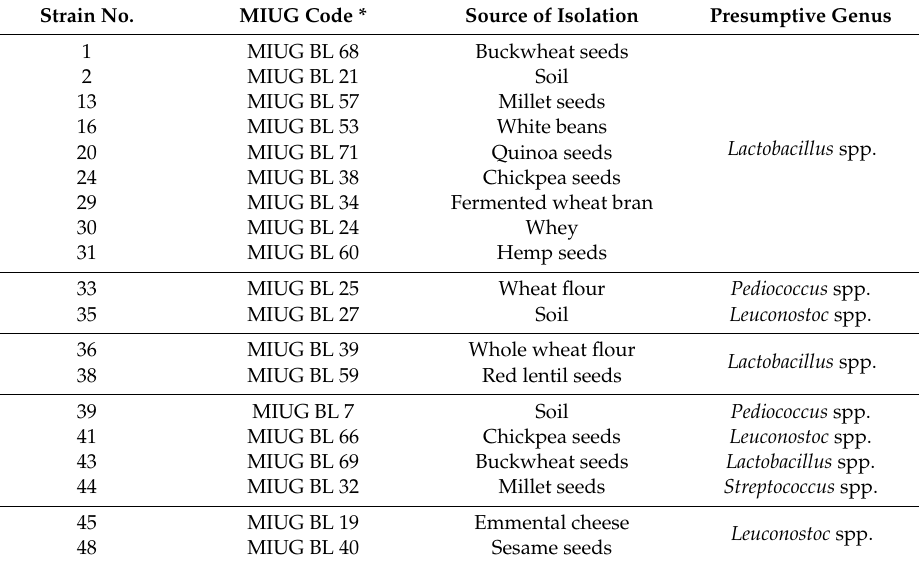
Table 1. Raw materials used for the isolation of microorganisms and encoding of the presumptive by Lactic Acid Bacteria (LAB) strains for further